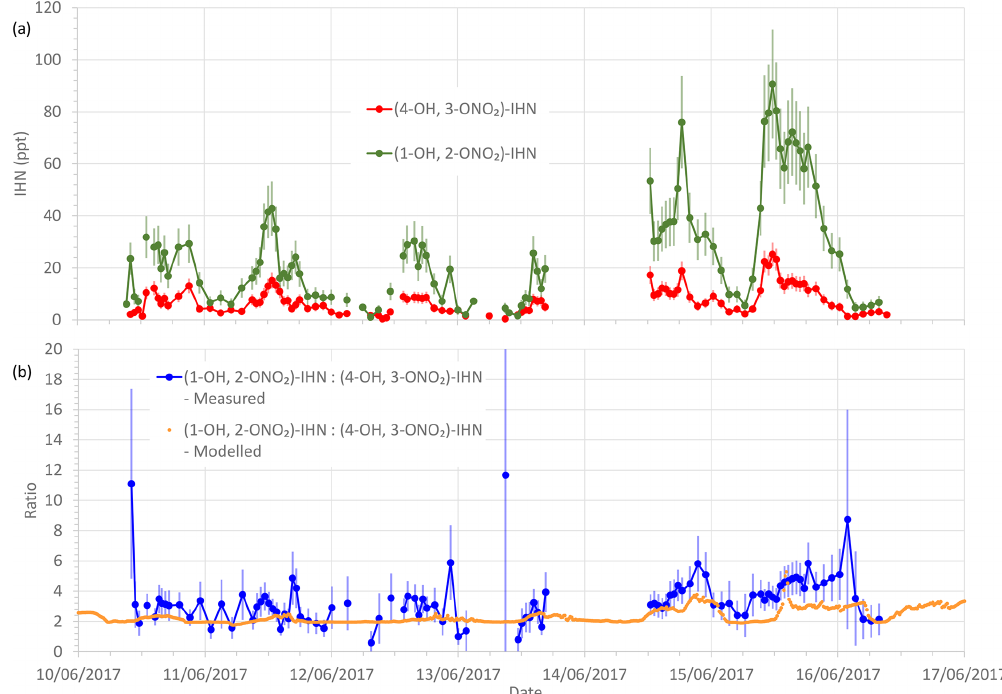
Figure 3. (a) Measured β -IHN mixing ratios. (b) Measured and modelled ratio (1-OH, 2-ONO 2 )-IHN:(4-OH, 3-ONO 2 )-IHN. Error bars are the measurement uncertainties (see Sect. 3.3 for details).